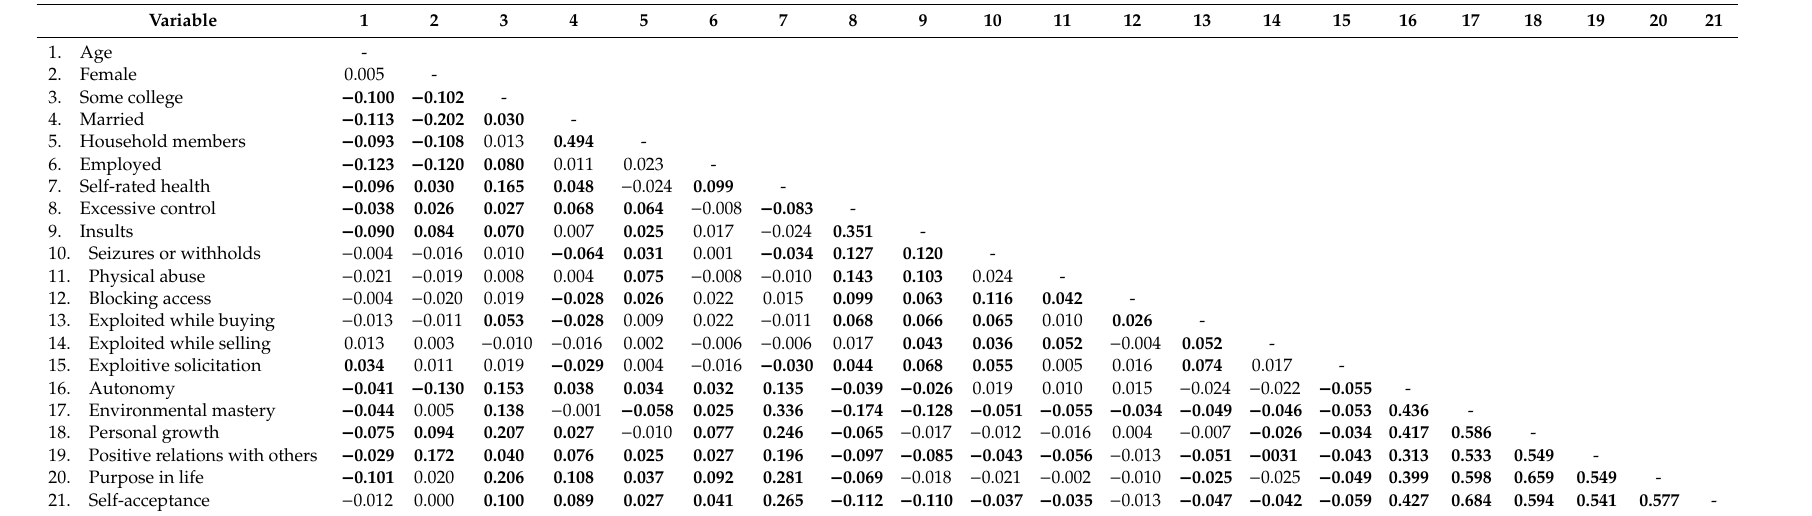
Table 4. Pearson correlation coe ffi cients 1